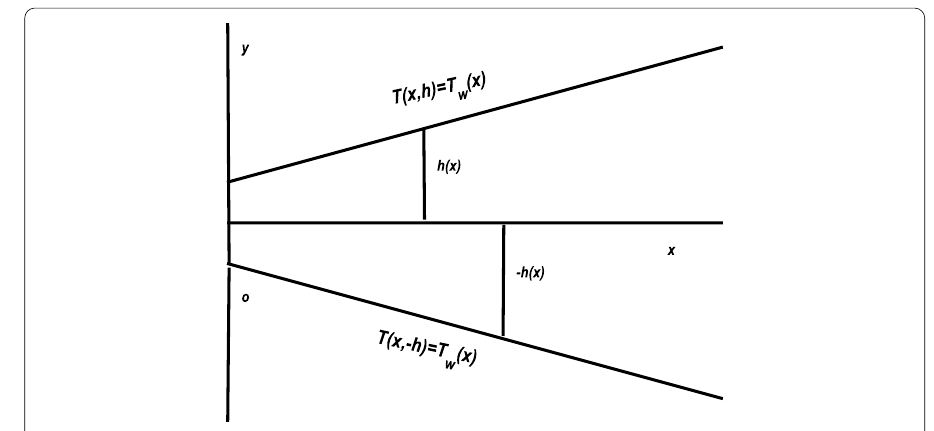
Fig. 1 The converging (diverging) channel and geometry of the